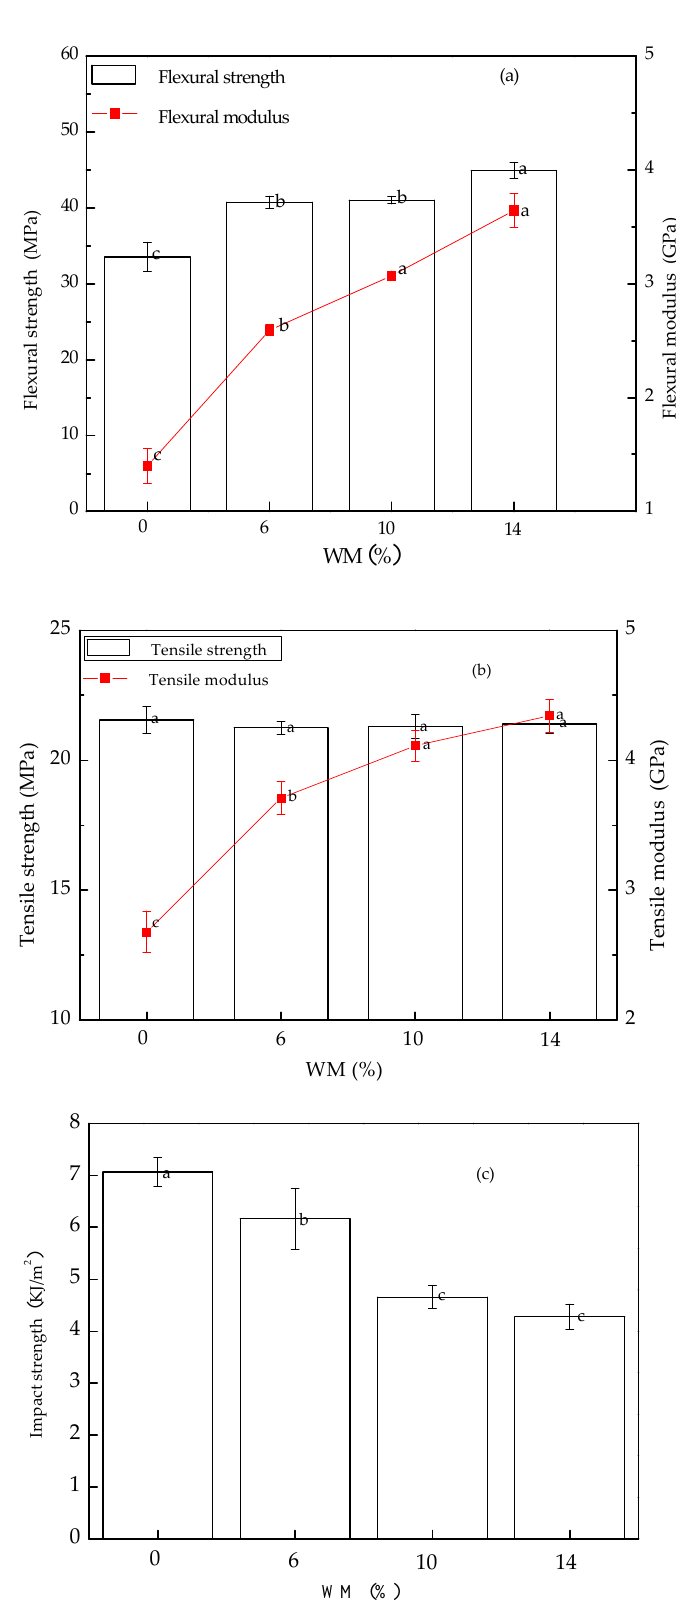
Figure 5. Effects of WM on mechanical properties of BPCs: ( a ) effects of WM on flexural property of BPCs; ( b ) effects of WM on tensile property of BPCs; ( c ) effects of WM on impact property of BPCs. Letters a, b, c denote significance test.